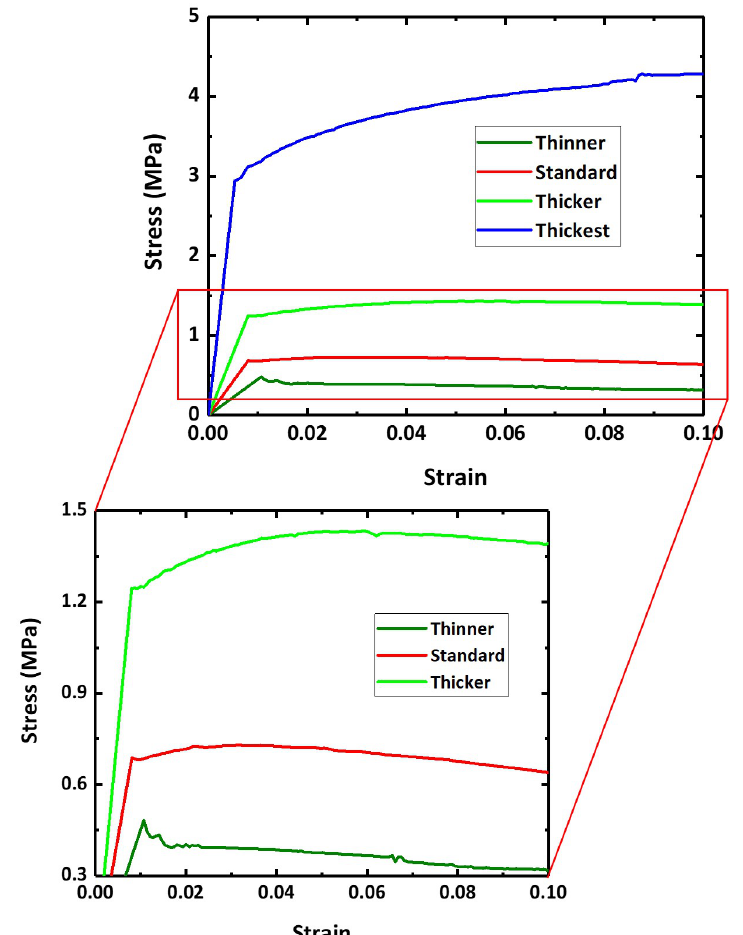
Figure 13. Predicted flow curves of various model domains with different strut thickness. Figure 13: Predicted flow curves of various model domains with different strut thickness